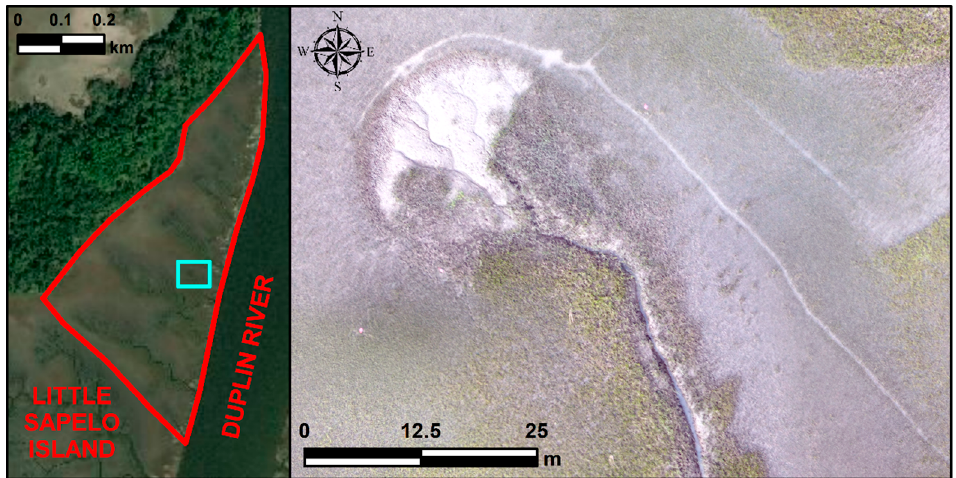
Figure 12. The progressive effect of continuous survey activities in the salt marsh is the creation of pathways in the vegetation (right), causing its death, and the creation of a preferential route for the water movement and stagnation.